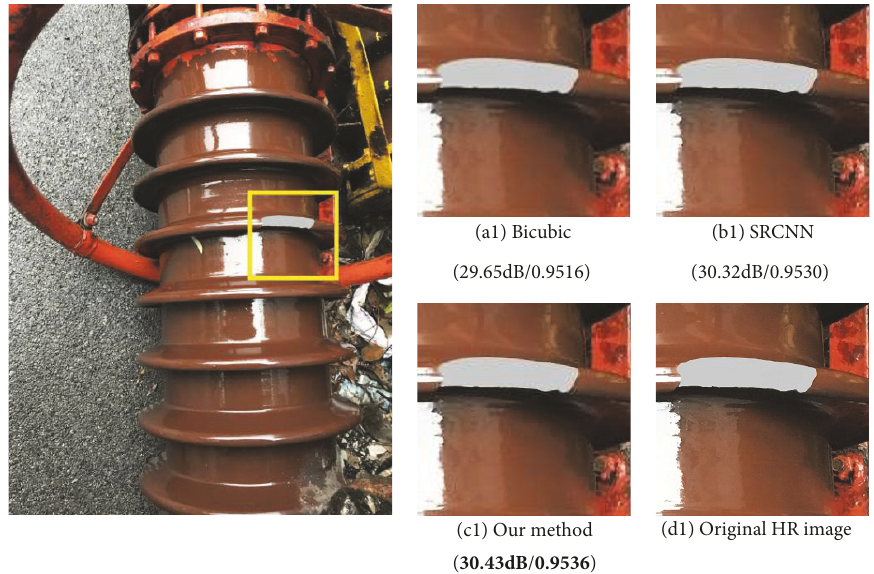
Figure 5: Simulated gaps fault in the ceramic